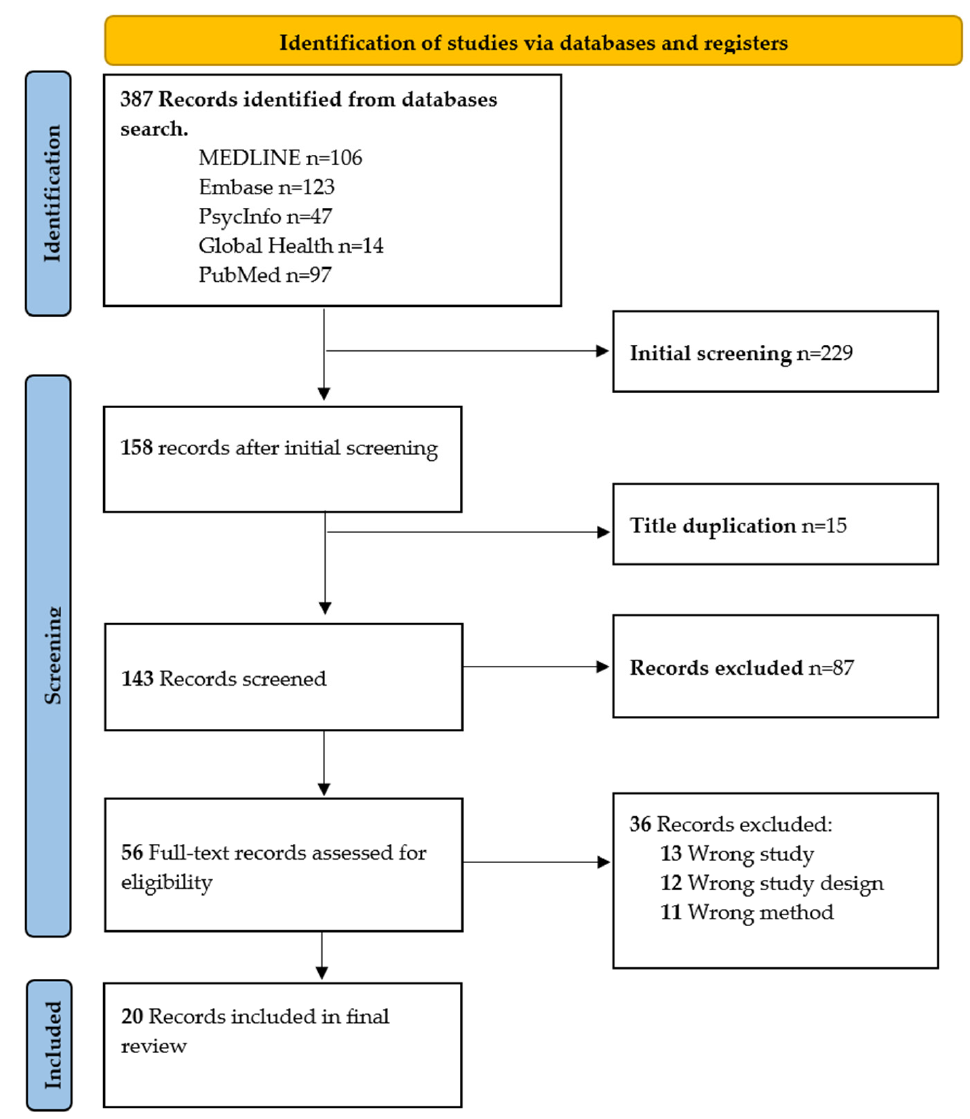
Figure 1. PRISMA Diagram.